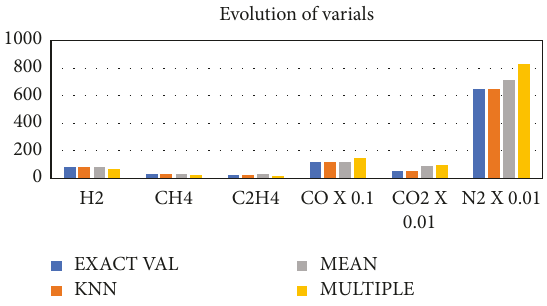
Figure 2: Evolution of imputed